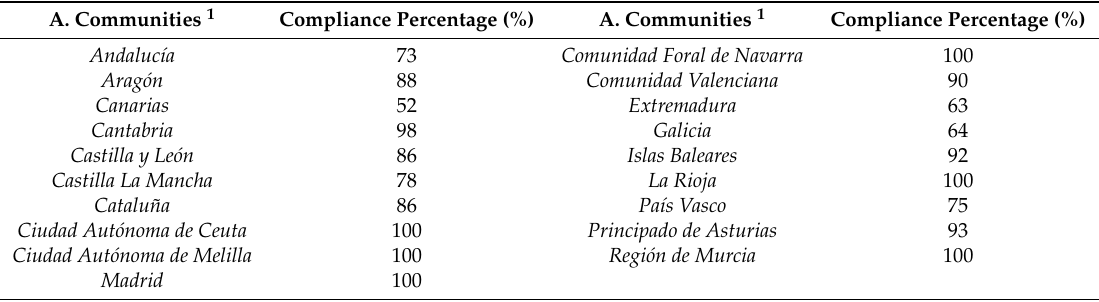
Table 1. Compliance degree of Spanish Autonomous Communities with the Directive 91 / 271 / EEC. Reference year: 2010. Source: own elaboration based on